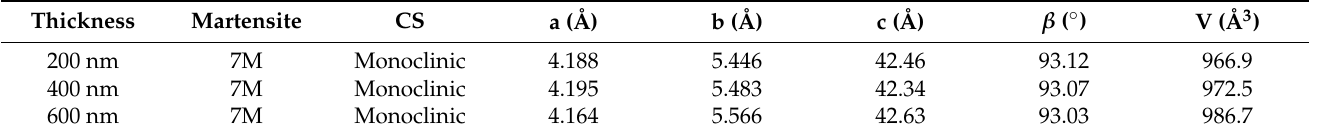
Figure 2. X-ray diffraction patterns of Ni 51.0 Mn 27.5 Ga 21.5 thin films at various azimuth angles (Phi) and tilt angles (Psi). ( a ) 200 nm, ( b ) 400 nm, and ( c ) 600 nm. Table 1. The lattice parameters of Ni 51.0 Mn 27.5 Ga 21.5 thin films on Al 2 O 3 substrate.